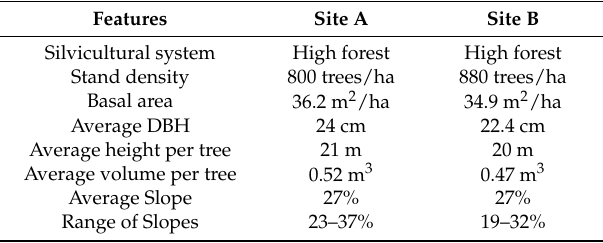
Figure 1. Location of case study. Table 1. Test site characteristics.